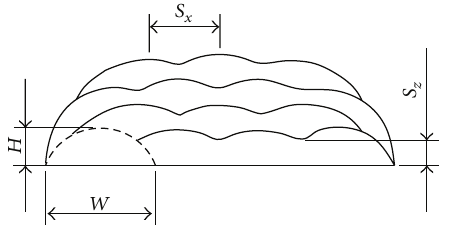
Figure 2: Schematic drawing of the cross-section of a deposited specimen.